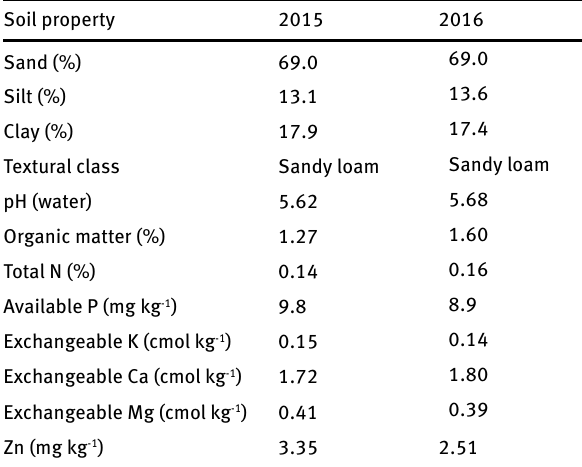
Table 1: Initial soil physical and chemical properties of the